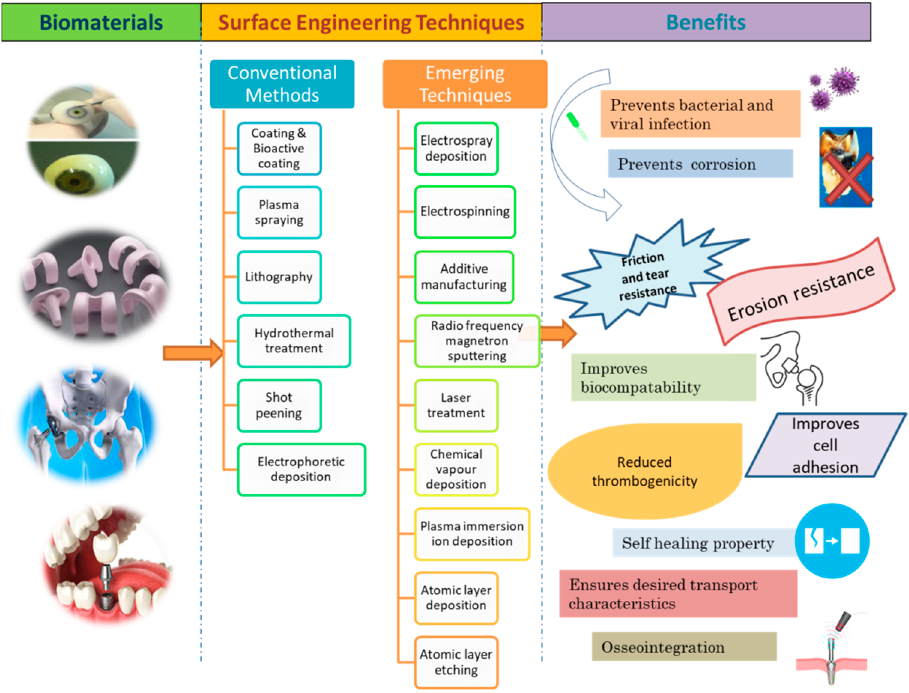
Figure 4. Schematic representation of different kinds of implants along with the few surface engi- neering techniques that can be used for surface modification in order to attain desired attributes such as antimicrobial, anticorrosive, osseointegration, biocompatibility, and self-healing property.